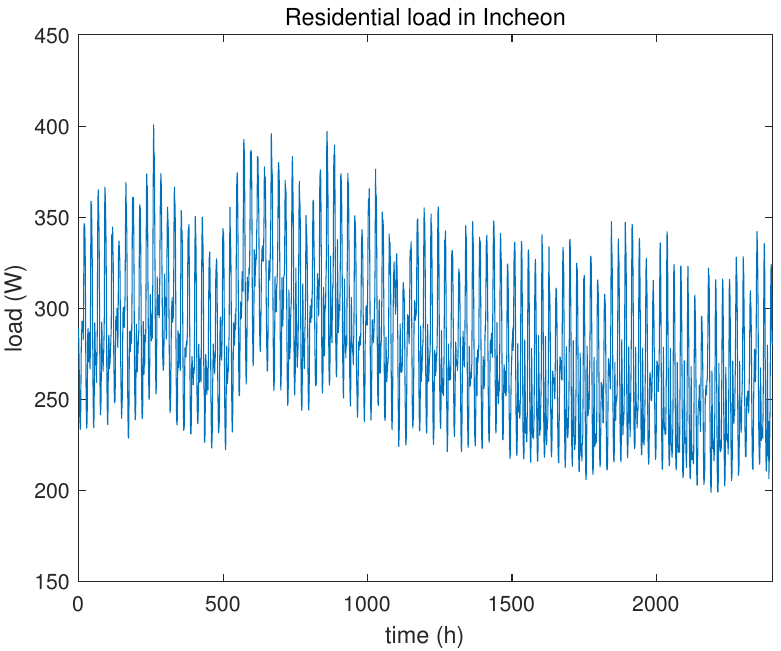
Figure 8. Load in the residential sector for one hundred